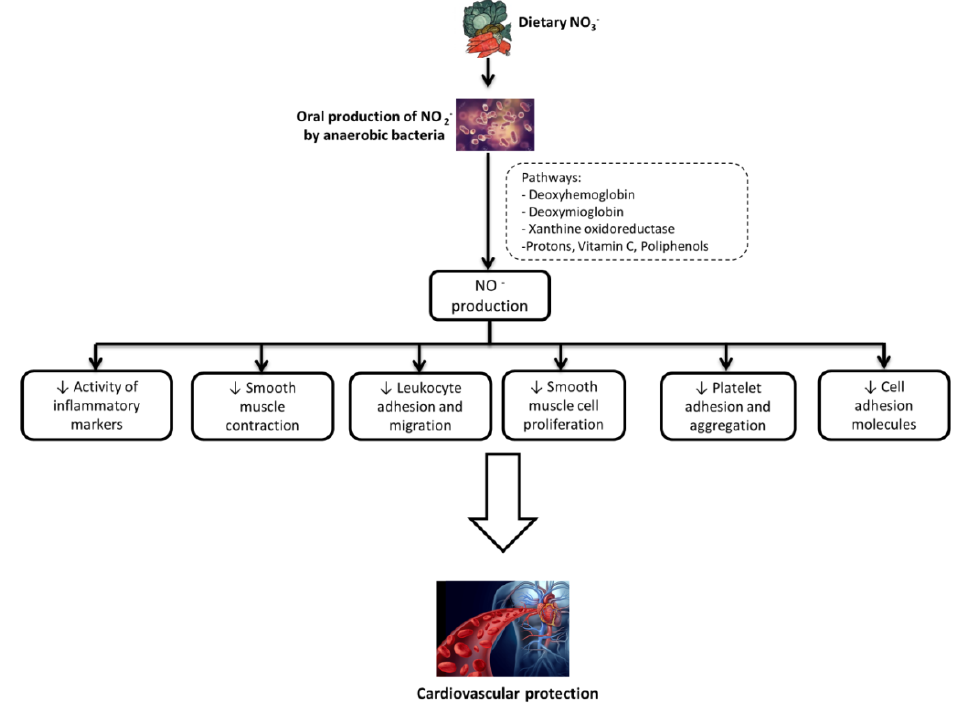
Figure 2. Mechanisms of cardioprotection by plant inorganic nitrates (NO 3 -).